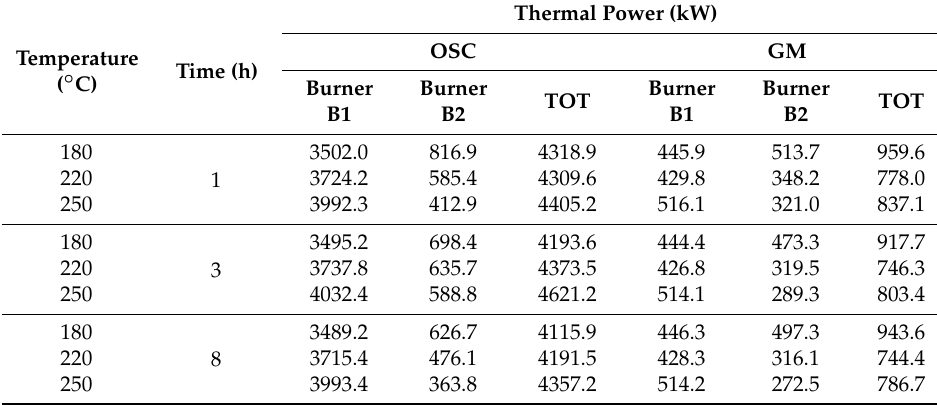
Table 3. Thermal power required at different HTC process conditions for OSC and